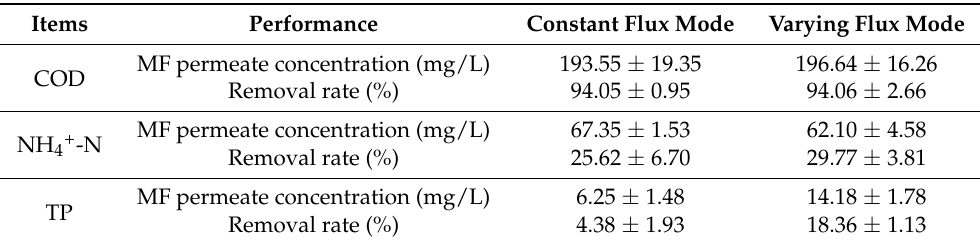
Table 1. COD, TP, and NH 4+ -N concentrations in MF permeates and the removal performances at different operating modes.